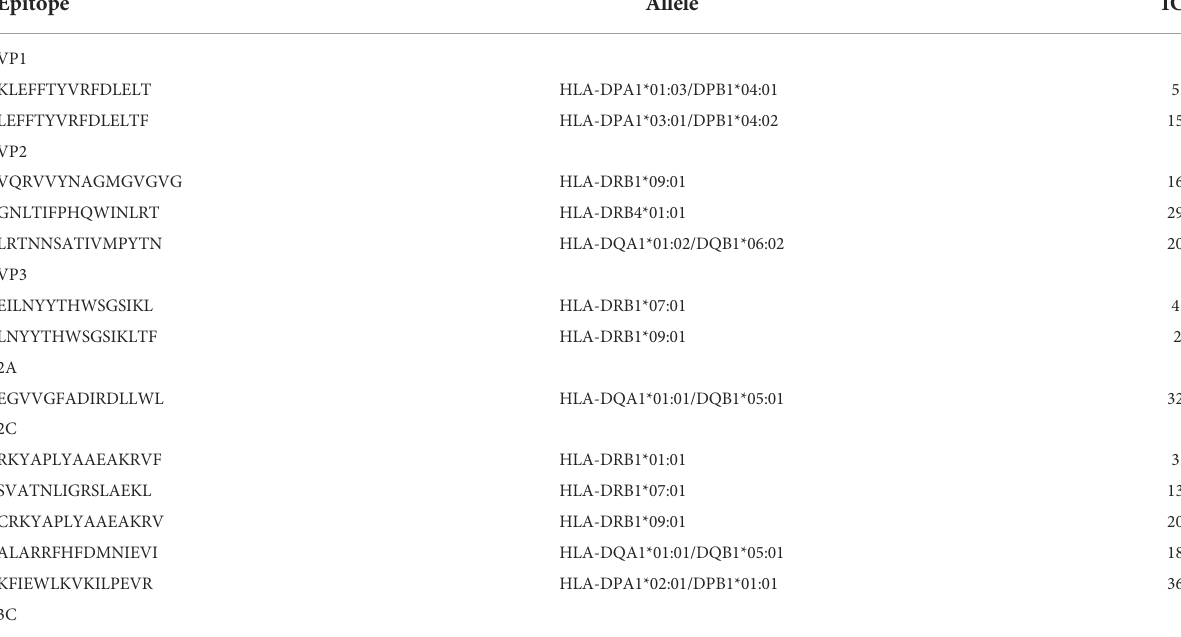
TABLE 3 Predicted helper T lymphocyte (HTL) epitopes of CVB proteins utilized for the construction of a multi-epitope vaccine. Epitope